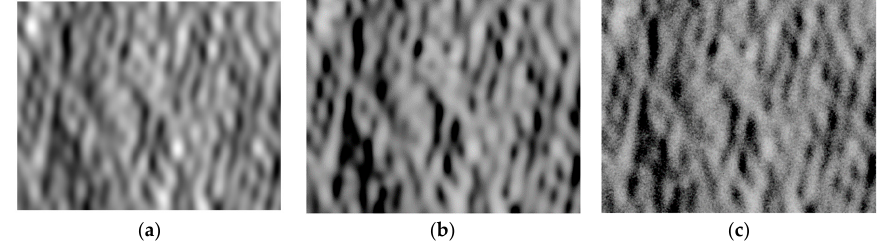
Figure 16. Local incidence angle map: ( a ) ground truth, ( b ) estimated from SAR image without speckle, ( c ) estimated from 10 × 10 spatial multilook speckled SAR image. Grayscale is in the range 24°–38°. Table 3. Quality measures for the sinusoidal DEM: without speckle. Elevation (m) Range Slope ( ◦ ) Azimuth Slope ( ◦ ) Error Magnitude Median Mean Std dev Median Mean Std dev Median Mean Std dev